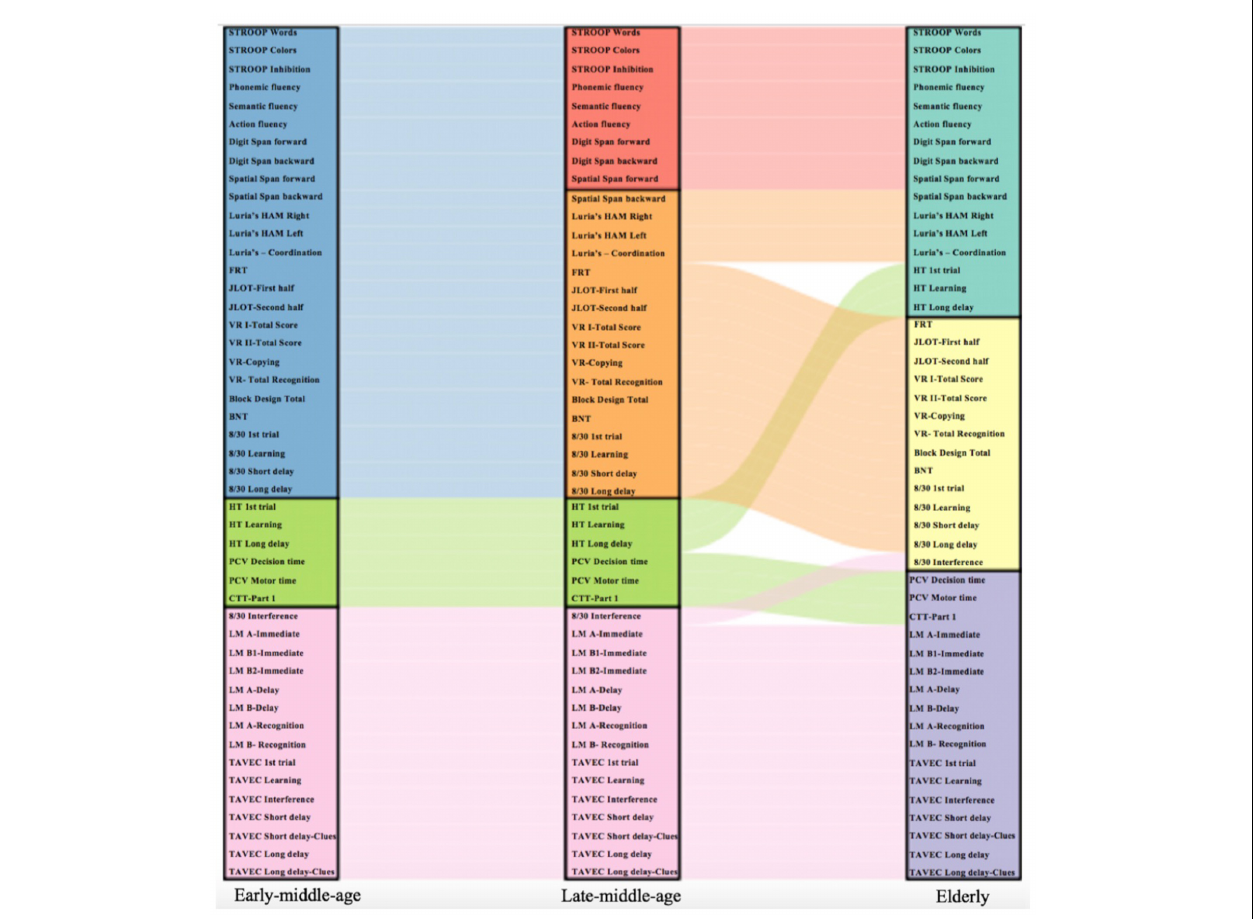
FIGURE 6 | Cognitive variables included in each cognitive module for each age group. The alluvial plot shows how each cognitive variable flows across the cognitive modules in each age group. The Newman algorithm was used for modular analysis. Each cognitive module is represented with a different color: blue color represents an executive and premotor, visual memory and visuospatial functions module; green color represents a procedural memory and processing speed module; pink color represents a verbal memory module; red color represents an executive functions module; orange color represents a premotor functions, visual memory and visuospatial functions module; turquoise color represents a procedural memory, executive and premotor functions module; yellow color represents a visual memory and visuospatial functions module; and violet color represents a verbal memory and processing speed module. Schematic representation of cognitive modules using Newman and Louvain algorithms are detailed in Supplementary Figures 5, 6 , respectively.